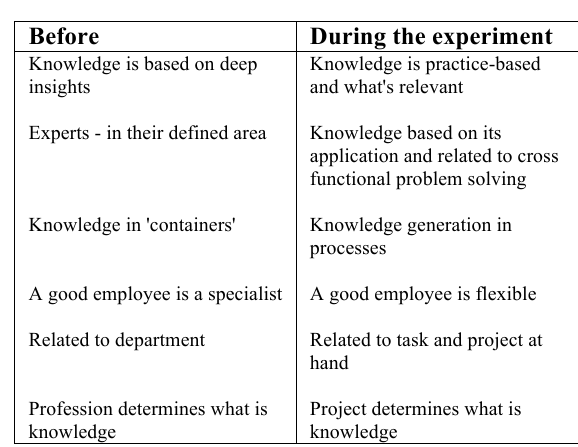
Table 2. Meaning of management before and during the in- vivo experiment in Oticon, as reported in the papers that analysed the case, using the lenses of the Dionysian perspective to analyse it. During the experiment Table 3. Meaning of knowledge before and during the in-vivo Stable structure and functional experiment in Oticon, as reported in the papers that analysed managers as gatekeepers. the case, using the lenses of the Dionysian perspective to analyse